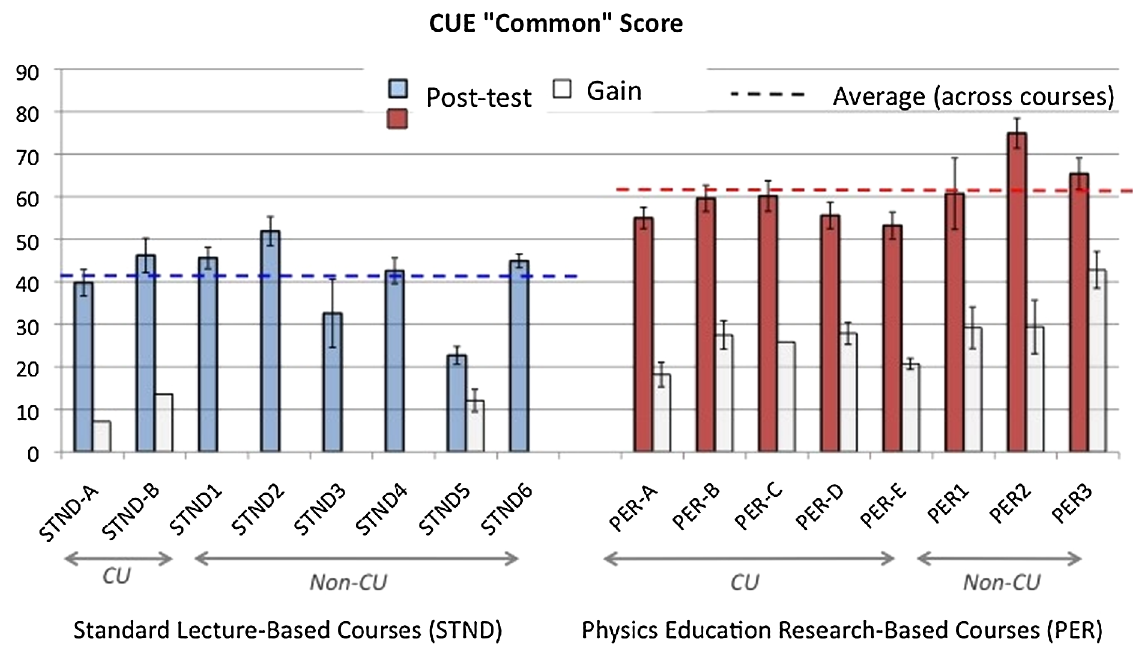
FIG. 1 (color online). CUE scores across institutions for N ¼ 488 students. ‘‘Post-test’’ represents course average score (% correct) for the subset of CUE questions given in common across all exams (88 out of 118 possible points). ‘‘Gain’’ represents the course average for the difference between the pretest and the subset of the post-test which matches the pretest. Because of the lack of pretests for PER-C and STND-A and STND-B, pretest scores are estimated based on the stable pretest scores (33%) for other semesters of PHYS301 at CU. Error bars represent 1 standard error of the